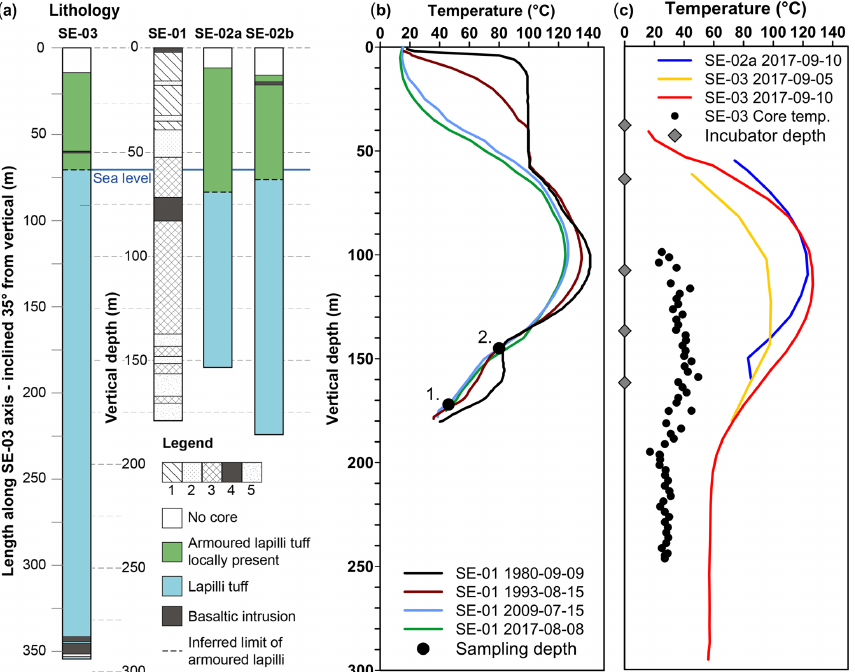
Figure 2. Comparisons of the 1979 and 2017 cored Surtsey boreholes. ( a ) Lithological logs. The 1979 core: SE-01 (following Jakobsson and Moore, 1982). (1) Weakly altered hyaloclastite, brown-black; (2) coarse and poorly graded hyaloclastite, black; (3) sound hyaloclastite, greyish-green; (4) basaltic intrusions and lava (at top), black; and (5) incoherent tephra. The 2017 simplified core logs: SE-02a, SE-02b, and SE-03 (following Weisenberger et al., 2019). ( b ) Borehole temperatures: SE-01 with 1980, 1993, 2009, and 2017 measurements, as well as 2009 microbiological samples (1, 2) (Jakobsson and Moore, 1982; Jakobsson et al., 2000; Marteinsson et al., 2015). ( c ) Borehole temperatures measured shortly after termination of drilling in SE-02b and SE-03 as well as depths of incubation experiments in